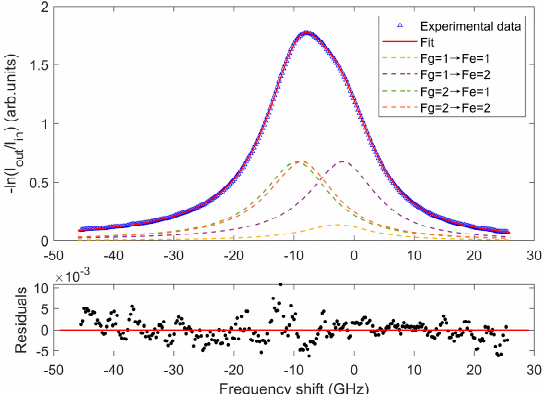
Figure 9. Fitting profile of the experimental results (368.8 K). The 87 Rb transitions between hyperfine levels of the ground and excited states of the D1 transitions are plotted as dotted lines.